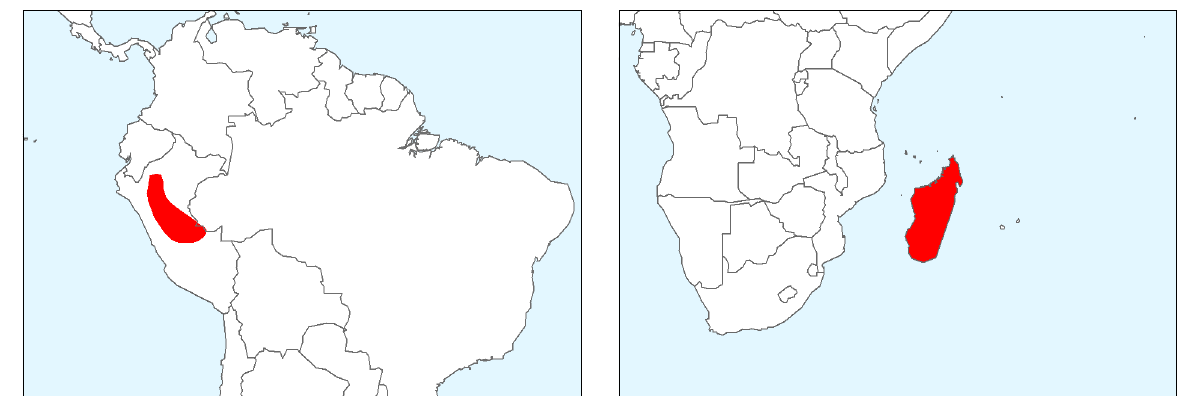
Fig. 5. Native range on mainland: Pachystachys lutea (left) and Cyperus alternifolius (right)